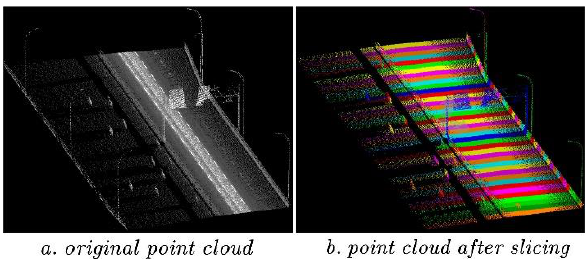
Figure 4. The comparing between the original point cloud and the slicing point cloud